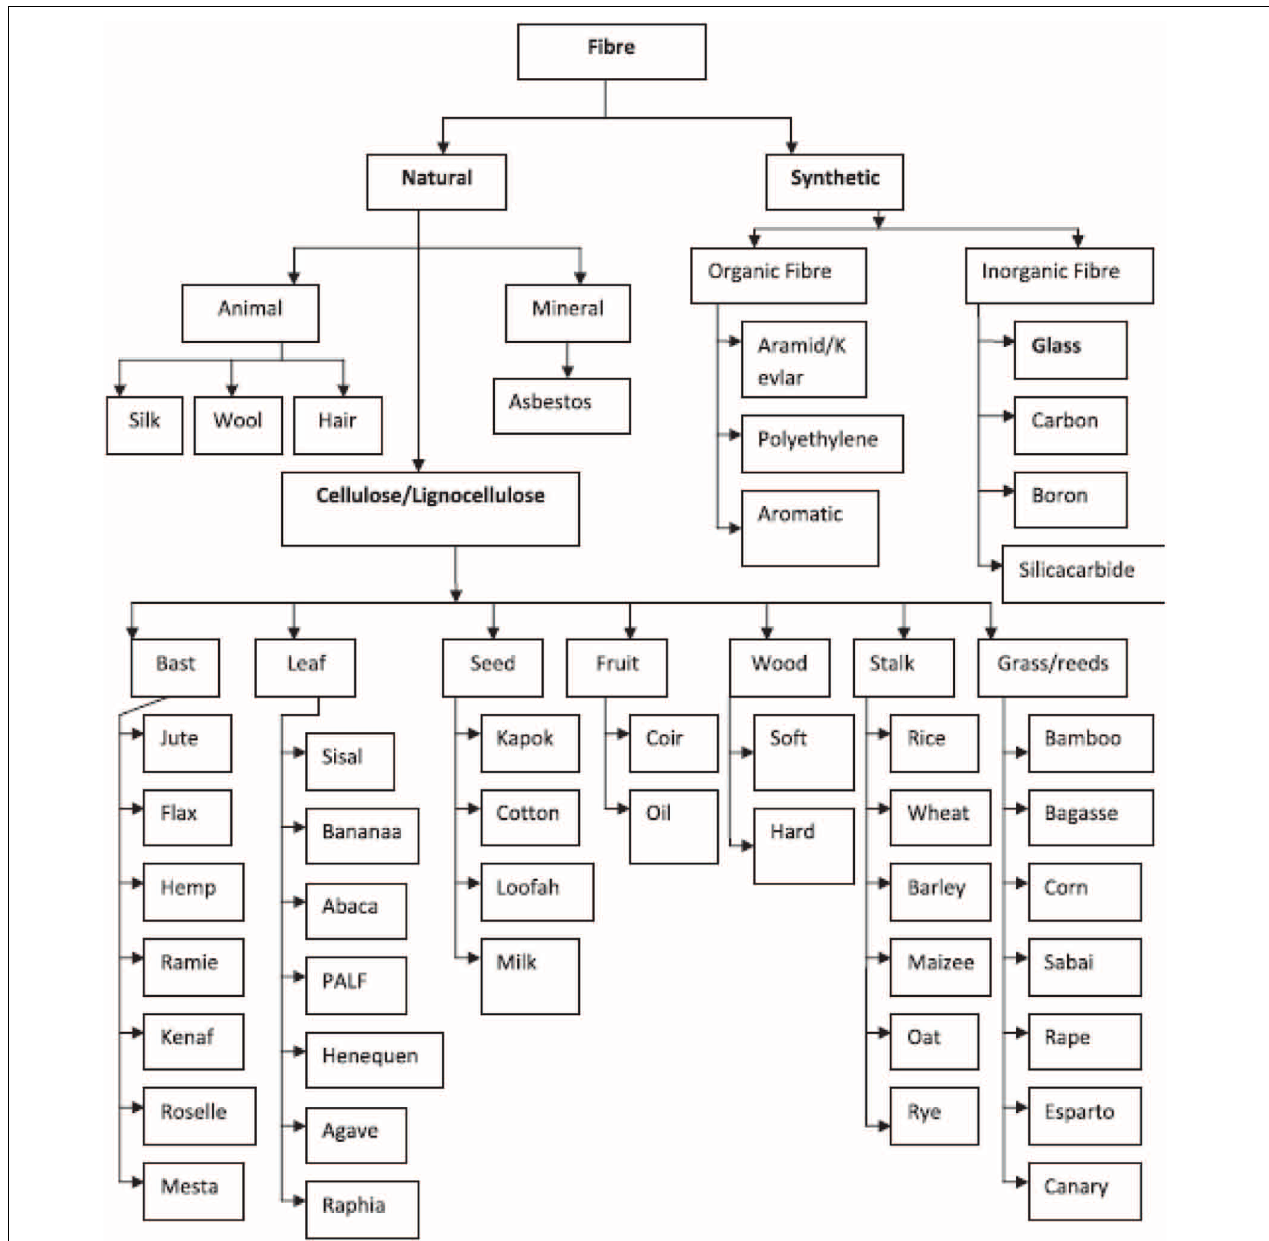
FIGURE 2 | Fibers classification (Majeed et al., 2013) (with permission).